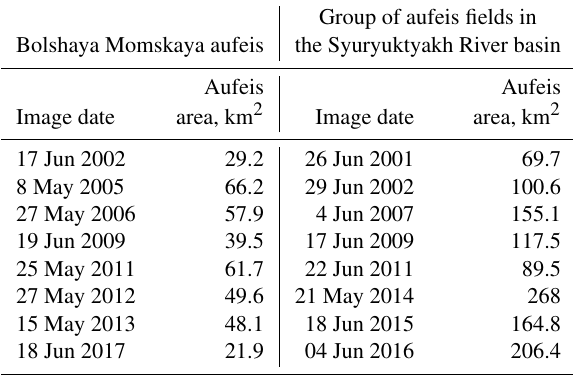
Table 5. Aufeis area changes,